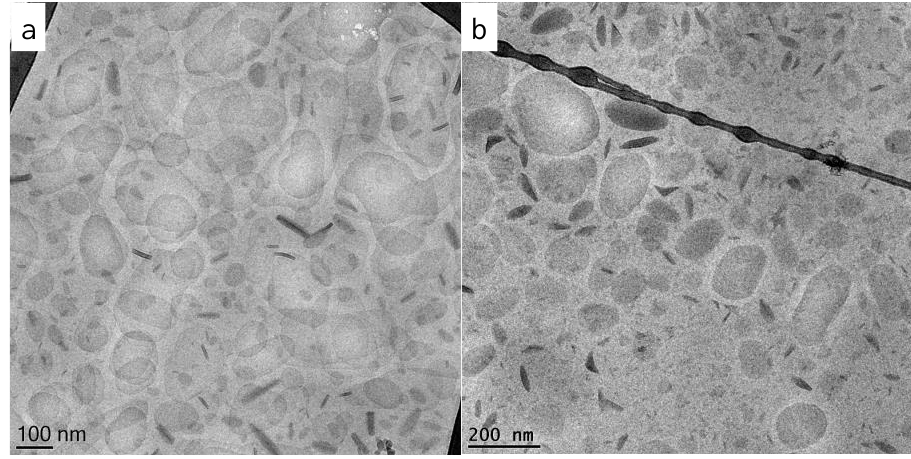
Figure 5. Cryo-TEM images of SLN ( a ) and NLC ( b ).